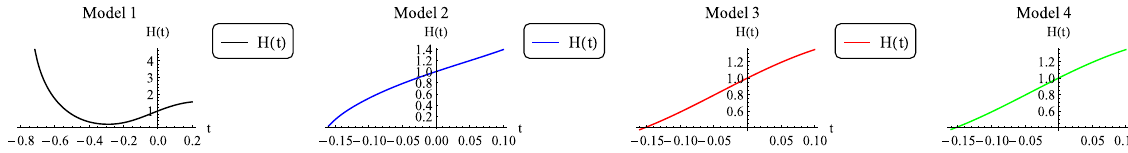
Fig. 3 The Hubble parameter, H ( t ) , in terms of cosmic-time under different viable models